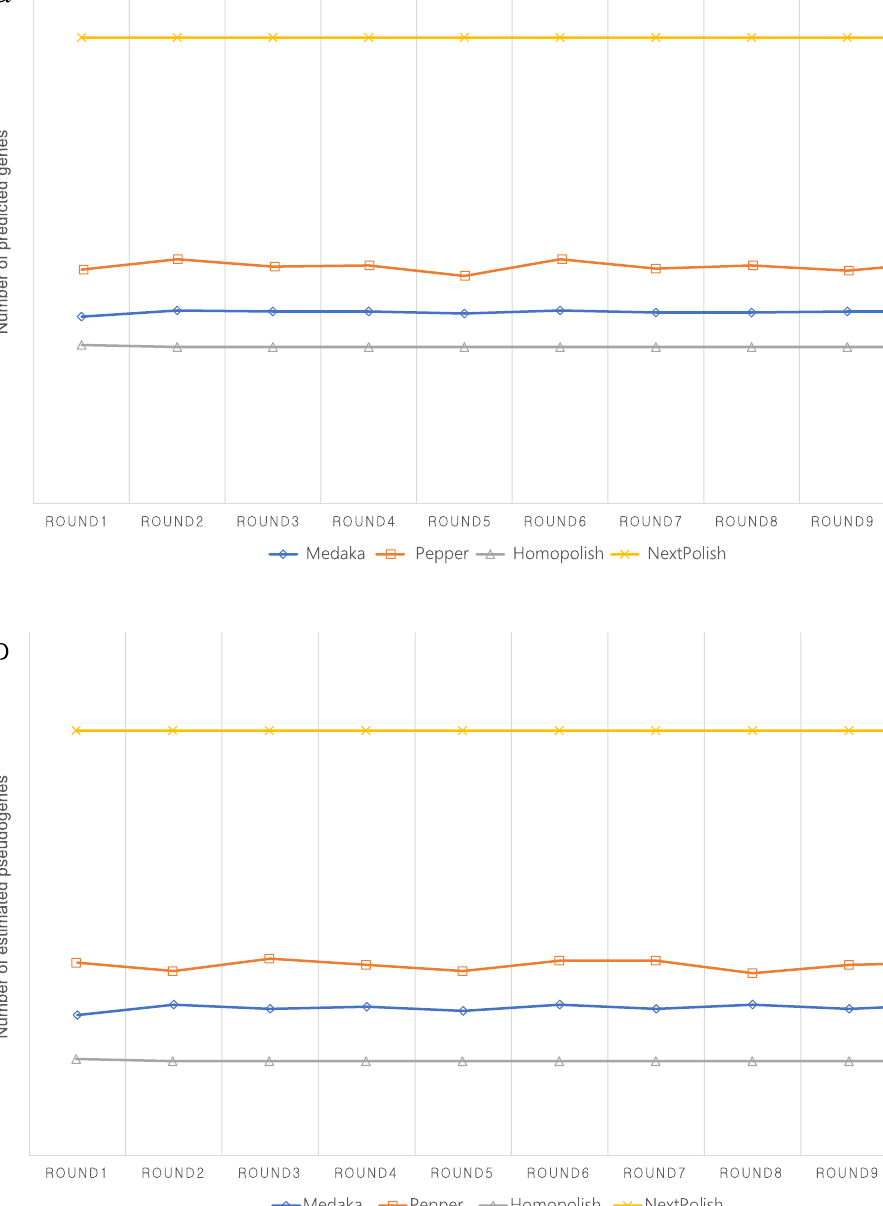
Figure 3. Prokka gene prediction result of 10 round iterative polishing for 4 polishing tools. ( a ) the number of predicted genes in each round, ( b ) the number of estimated pseudogenes in each